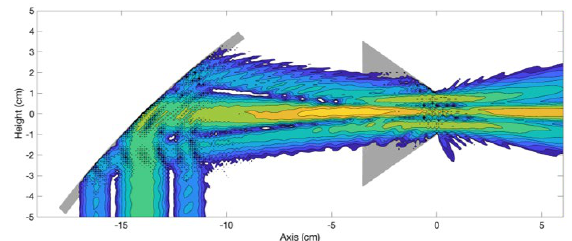
Fig. 6. Field intensity for HE 12 mode excitation. The incident mode is reflected off focusing mirror, and a small part is reflected back by cone funnel on the axis at 0 cm